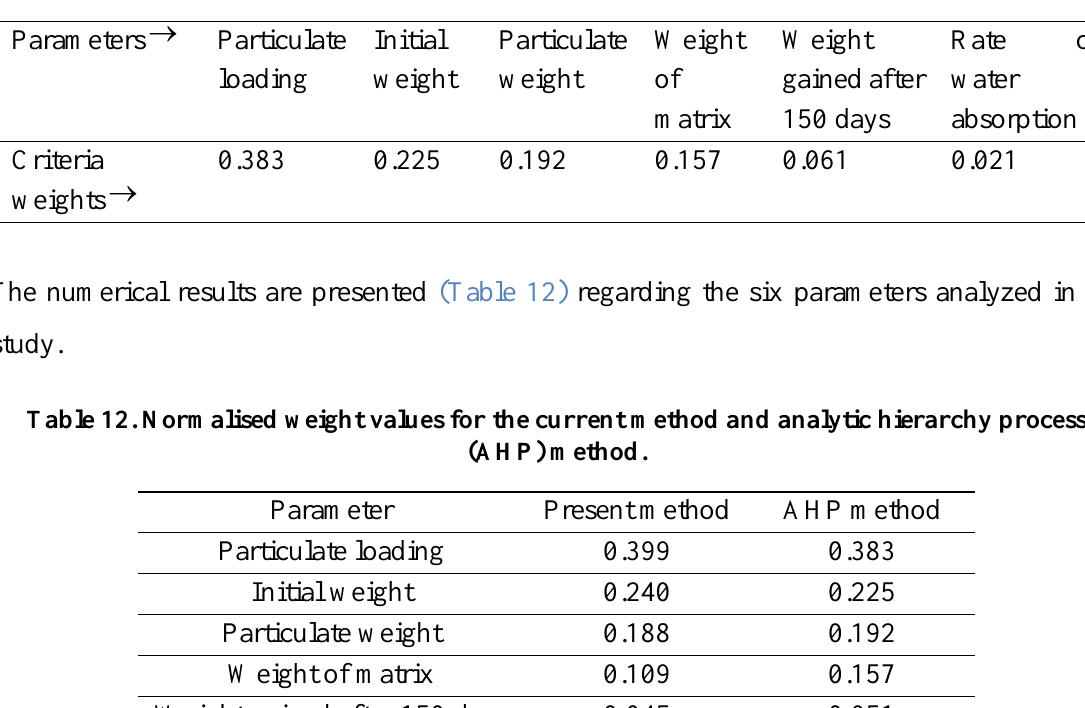
Table 11. The 6 x 6 matrix representing the values of the pairwise comparison for the cocoa pod husk composite.